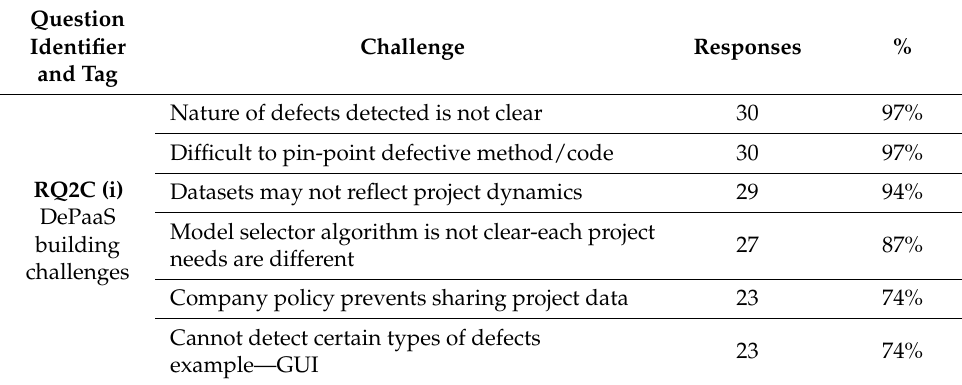
Table A2. Challenges to build, use and sustain